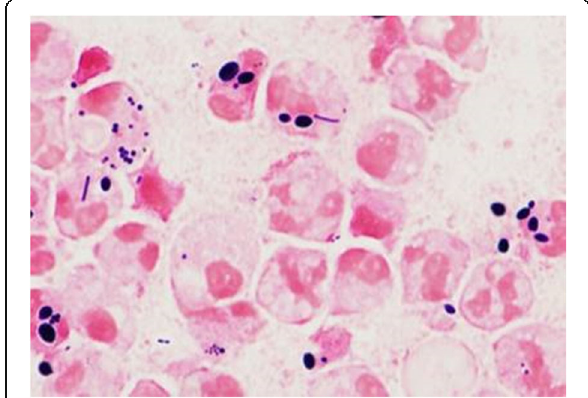
Fig. 2 Sputum Gram stain (case 4) at 1000x magnification, showing many WBC with intracellular yeast and Gram positive cocci. Culture yielded 2 × 10 7 C. albicans, 5 × 10 7 S. aureus , and 4 × 10